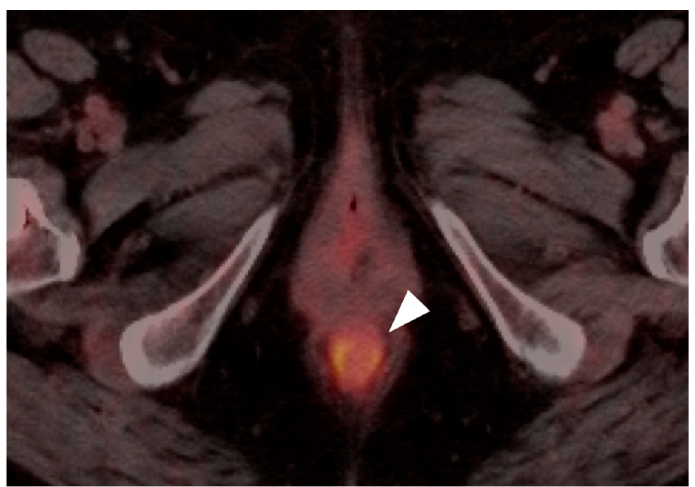
Figure 43. Normal anal sphincter (white arrowhead) is often hypermetabolic, typically assumes a circular shape (as in this axial fused FDG PET-CT of the low pelvis) and can mimic anal cancer.